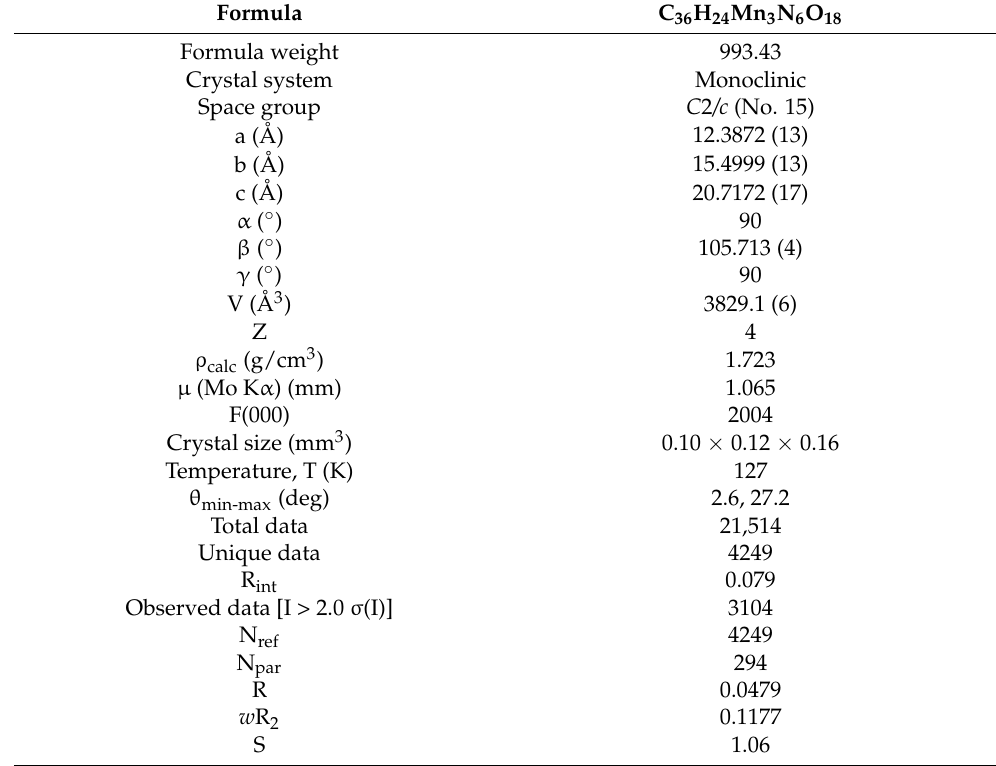
Table 1. Crystallographic data collection and refinement